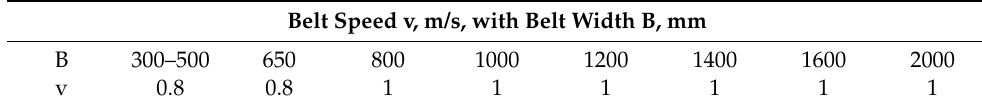
Table 1. Recommended speeds of the conveyor for root crops [18].